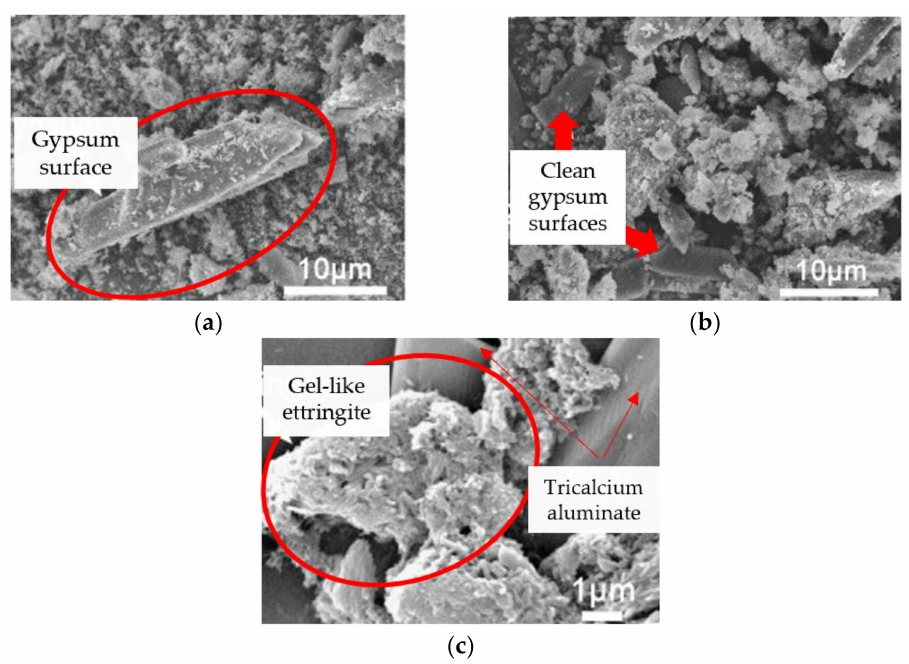
Figure 8. ( a ) SEM images of gypsum surfaces in the absence of welan gum. SEM images of ( b ) gyp- sum surfaces and ( c ) tricalcium aluminate surface partially covered with gel-like ettringite, in the presence pf 0.5% welan gum after 24 h into hydration [38].